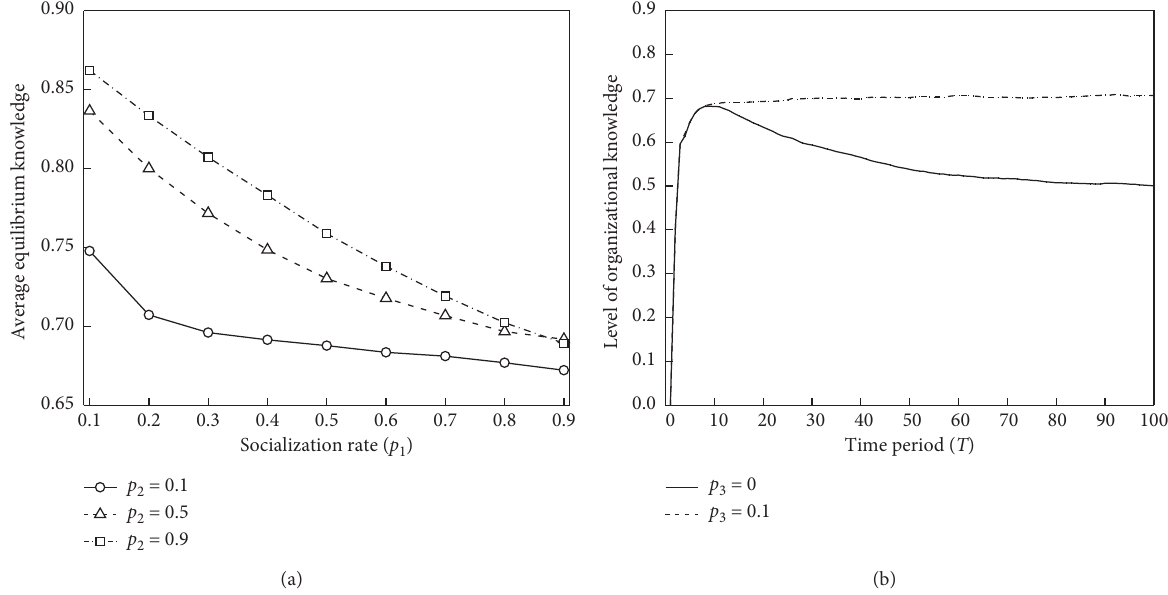
Figure 2: Result of replication. (a) Effect of learning rates ( p p 4 � 0). (b) Effect of environmental dynamism ( p 4 � 0.02) on level of organizational knowledge, with and without the inflow of external knowledge ( p 1 � 0.5; p 2 �